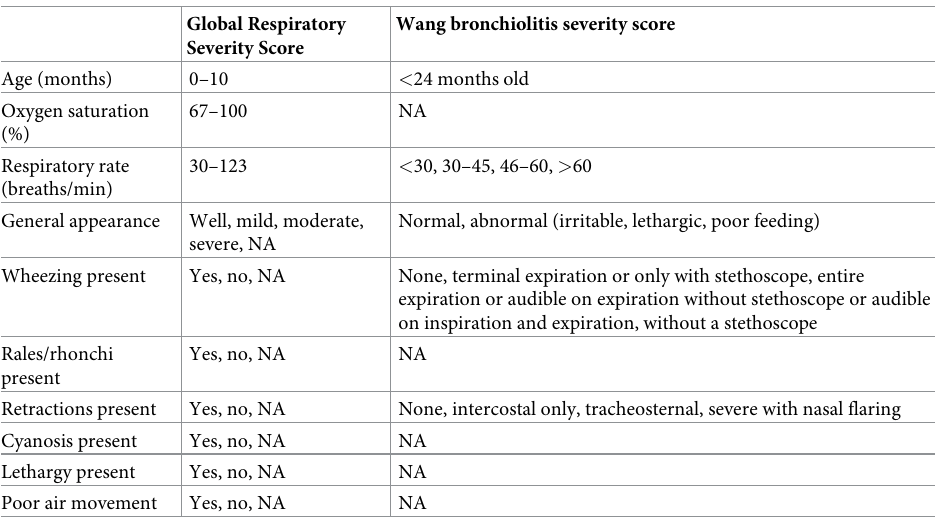
Table 1. Parameters of each scoring